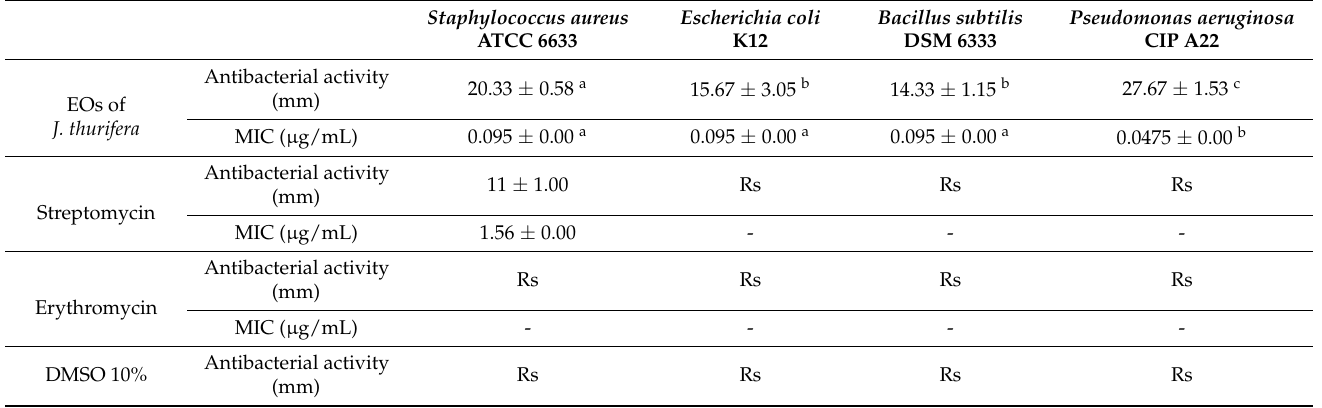
Table 2. Antibacterial activity of J. thurifera EOs in comparison with the antibiotics streptomycin and erythromycin. Staphylococcus aureus ATCC